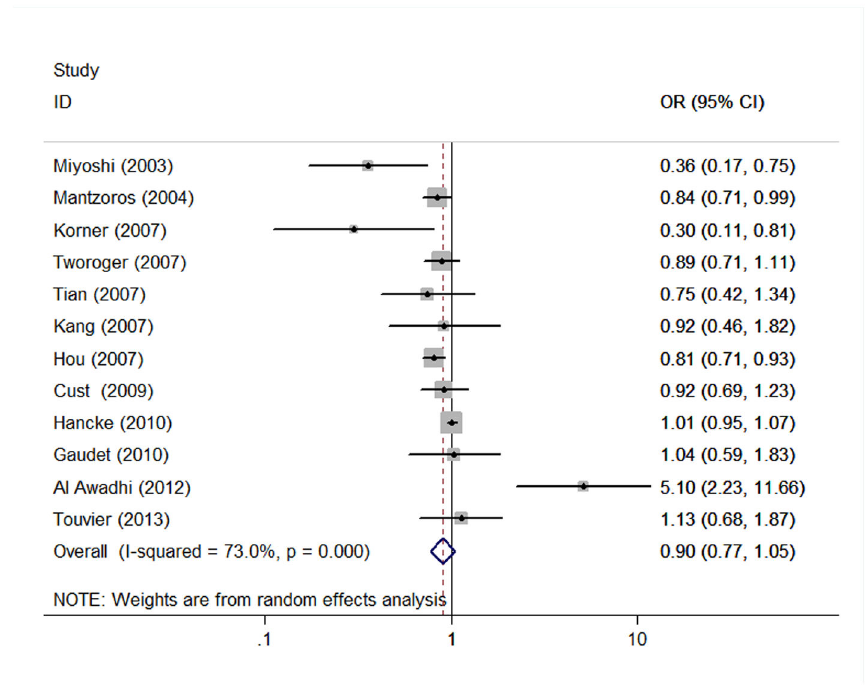
Figure 2. The effect of adiponectin on breast cancer